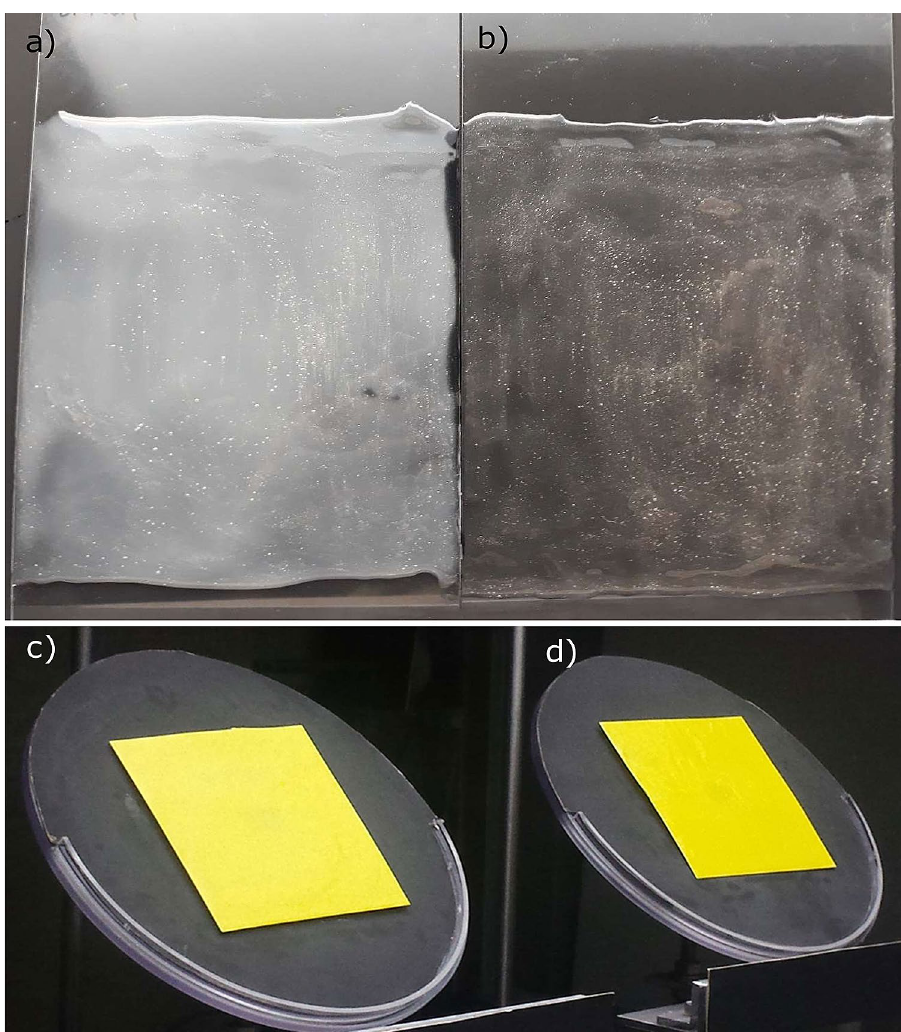
Figure 2. Light reflection in the wind tunnel on a clear or yellow plate with ( a , c ) Stikem glue or ( b , d ) D41